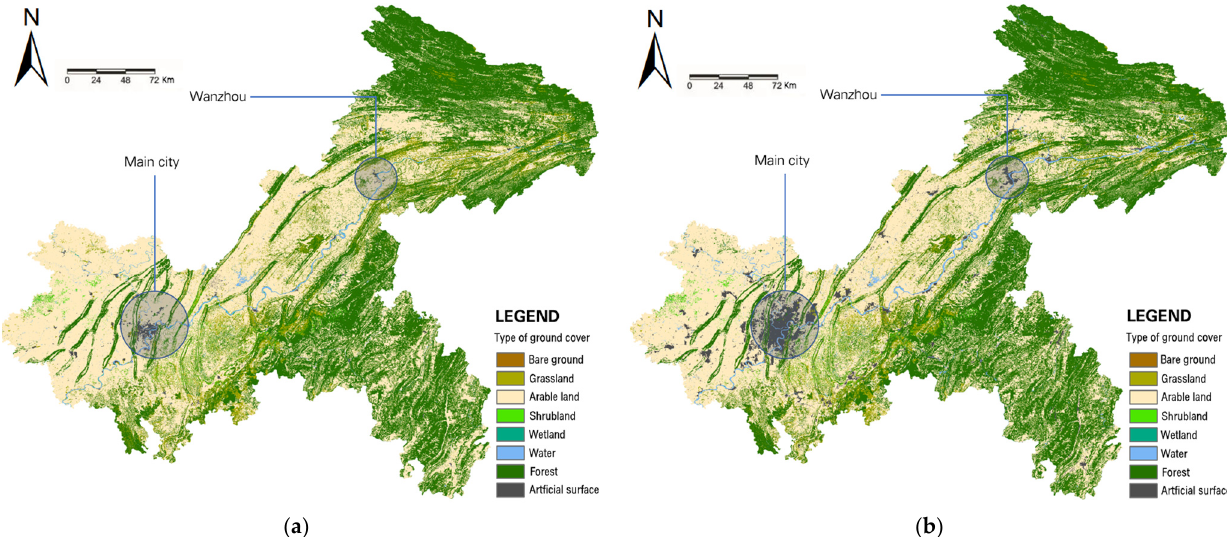
Figure 8. Changes in surface cover types in Chongqing; ( a ) type of surface cover in 2000; ( b ) type of surface cover in 2020.